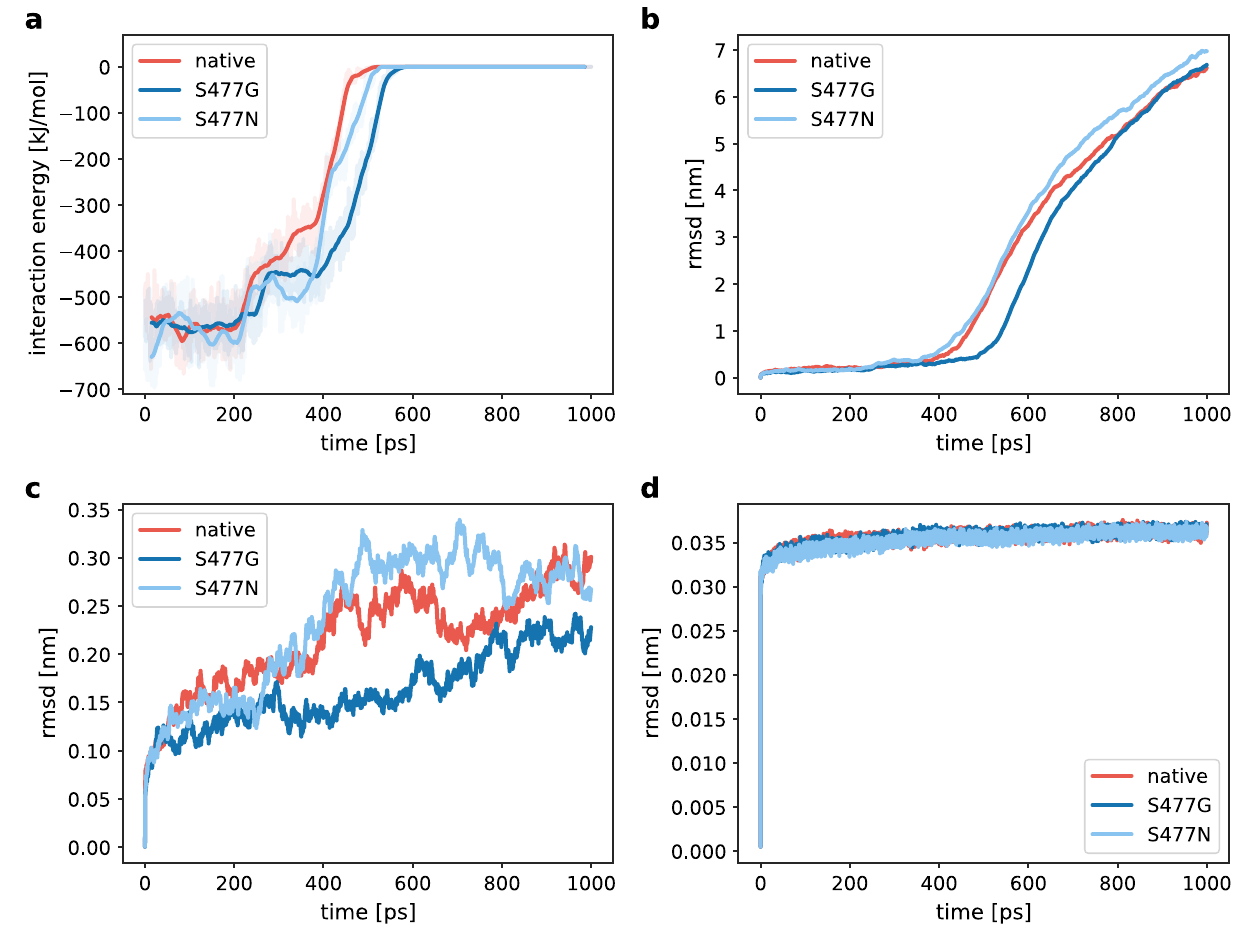
Figure 6. Energy and structural changes during SMD simulations with a spring force constant of 250 kJ/mol/ nm 2 . ( a ) Time dependence of the interaction energy between hACE2 and RBD. The shaded areas represent non- averaged data (frame rate 0.1 ps), whereas the lines represent window averages of 300 frames. ( b ) Comparison of the rmsd of the backbone carbon atoms in the RBD:hACE2 complex relative to the initial frame. ( c ) Comparison of the rmsd of the carbon atoms in the RBD backbone relative to the initial frame. ( d ) Comparison of the rmsd of the carbon atoms in the hACE2 backbone relative to the initial